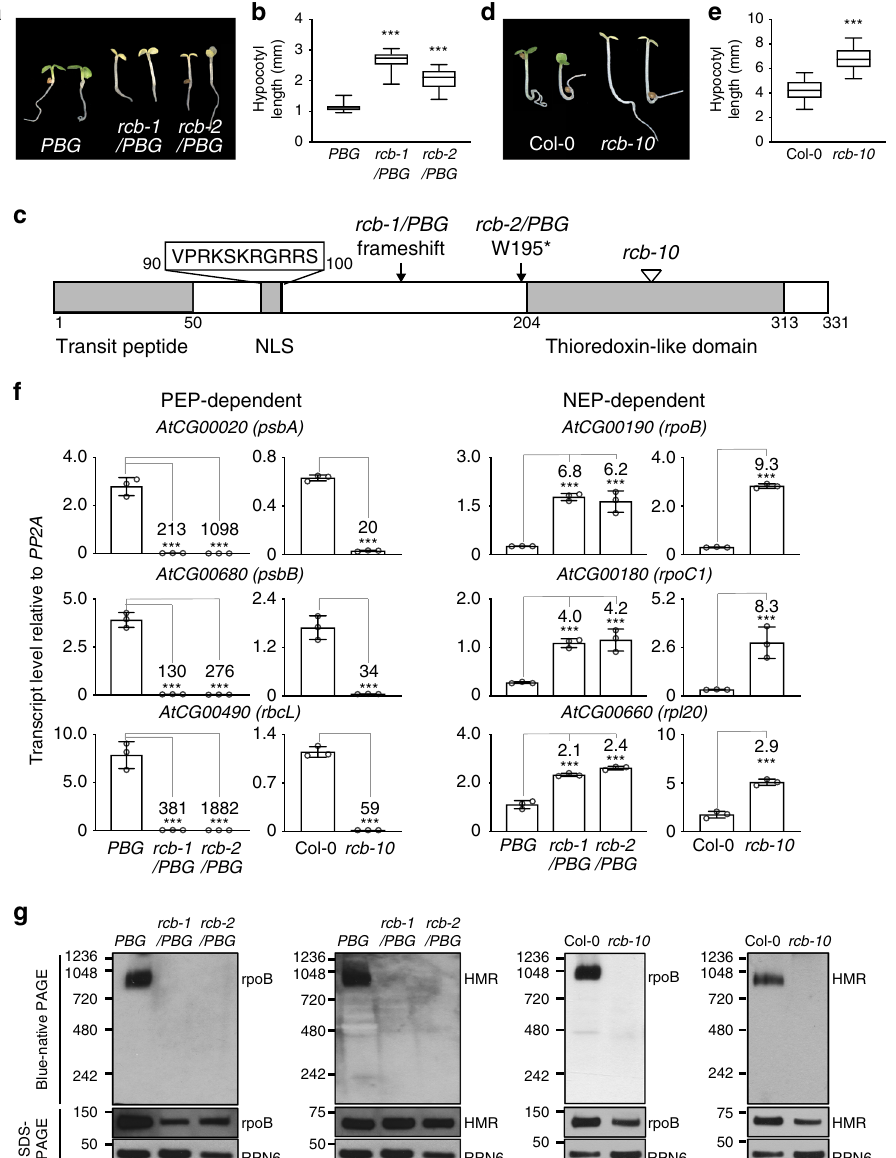
Fig. 2 Identi fi cation of RCB as a PHY signaling component required for PEP assembly. a Images of 4-d-old PBG , rcb-1/PBG , and rcb-2/PBG seedlings grown in 10 μ mol m − 2 s − 1 continuous R light. b Box-and-whisker plots showing hypocotyl measurements of seedlings in ( a ). The boxes represent from the 25th to the 75th percentiles, and the bars equal the median values. *** Indicates a statistically signi fi cant difference from the value of PBG (Student ’ s t -test, p ≤ 0.001). c Schematic illustration of the predicted domain structure of RCB. The mutations of the rcb alleles are indicated. NLS, nuclear localization signal. d Representative images of 4-d-old Col-0 and rcb-10 seedlings grown in 10 μ mol m − 2 s − 1 R light. e Box-and-whisker plots showing hypocotyl measurements of seedlings in ( d ). The boxes represent from the 25th to the 75th percentiles, and the bars equal the median values. *** Indicates statistically signi fi cant differences from the value of Col-0 (Student ’ s t -test, p ≤ 0.001). f qRT-PCR analyses of the transcript levels of representative PEP- and NEP-dependent genes in 4-d-old PBG , rcb-1/PBG , rcb-2/PBG , Col-0, and rcb-10 seedlings grown in 10 μ mol m − 2 s − 1 R light. Fold changes are shown for the rcb mutant samples exhibiting greater than twofold changes compared with the values of the corresponding parental-line samples (***, Student ’ s t -test, p ≤ 0.001). Error bars represent SD of three biological replicates. g Immunoblots showing the levels of the PEP complex (blue-native PAGE) as well as total rpoB and HMR proteins (SDS-PAGE) in 4-d-old PBG , rcb-1/PBG , rcb-2/PBG , Col-0, and rcb-10 seedlings grown in 10 μ mol m − 2 s − 1 R light. RPN6 was used as a loading control. The source data underlying the hypocotyl measurements in ( b ) and ( e ), the qRT-PCR analysis in ( f ), and immunoblots in ( g ) are provided